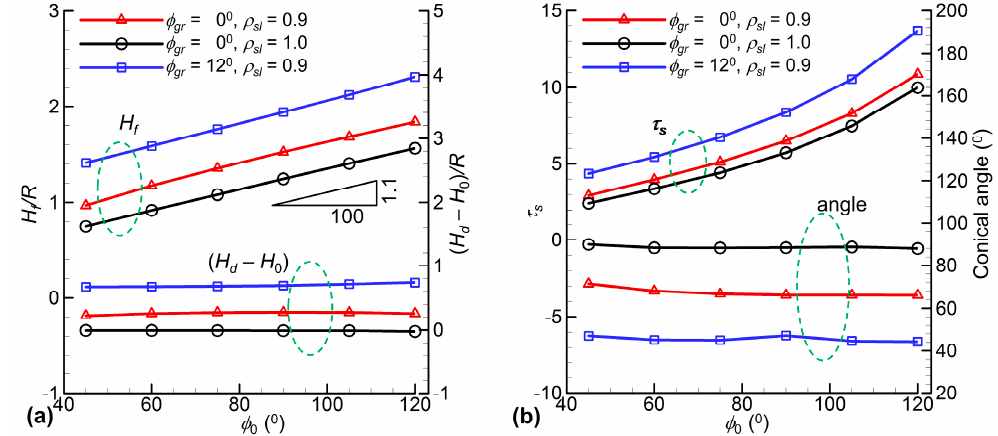
Figure 7. Effects of the contact angle, density ratio and growth angle on the solidification process: ( a ) the average height H f of the solidifying front at the final stage of solidification, and the difference height, H d – H 0 , between the final height after complete solidification ( H d ) and the initial height ( H 0 ); ( b ) the solidification time and the conical angle at the top of the solidified drop.